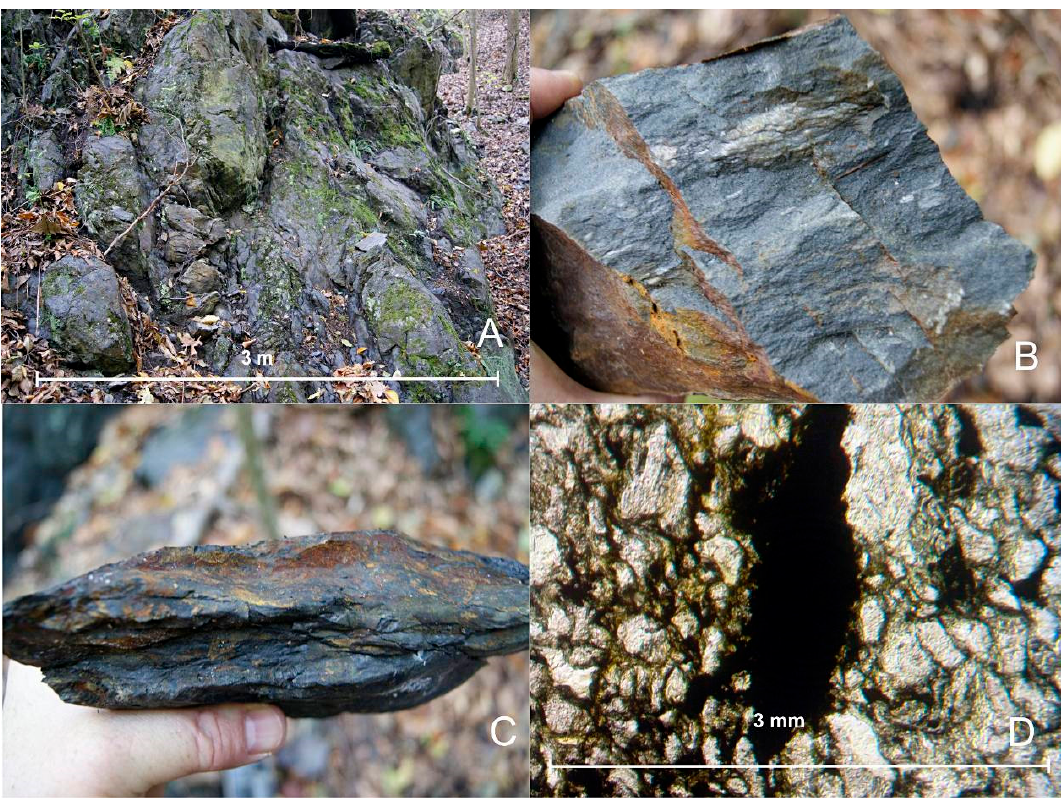
Figure 3. ( A ) Outcrop of graphitic schist from the Inovska Reka occurrence; ( B ) variety with more petrogenic minerals; ( C ) variety with more graphitic material; ( D ) thin section of the sample shown in ( C ).